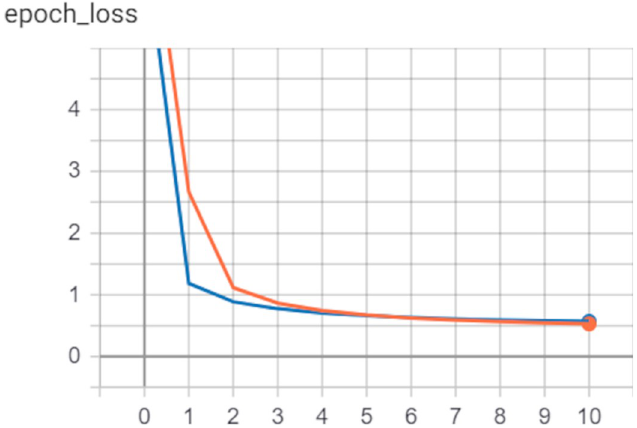
Fig 4. Loss value graph of validation and train at the 1st iteration of the of COG-A dataset. It shows that the DeepHiFam is not overfitting as there is rarely a gap between two curves.